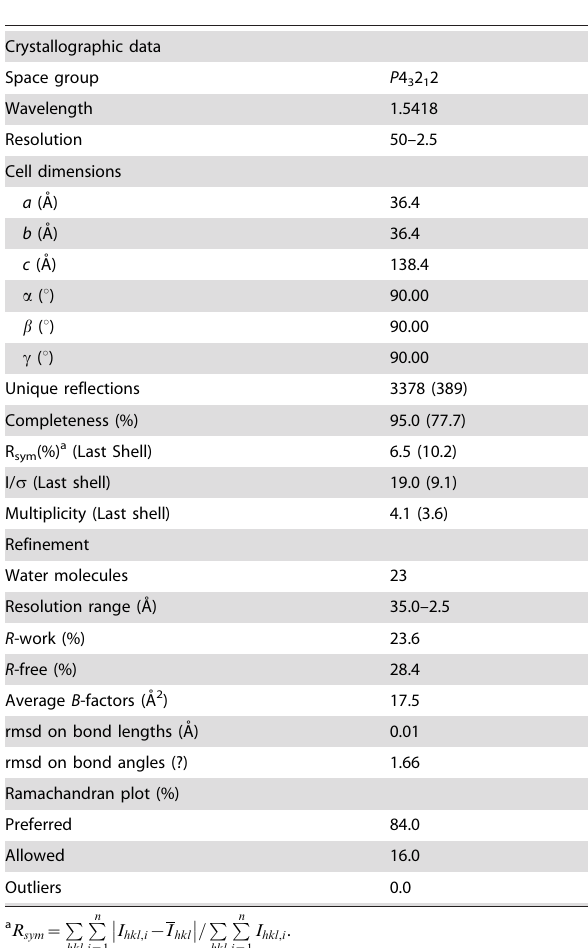
Table 1. Crystallographic data and results of